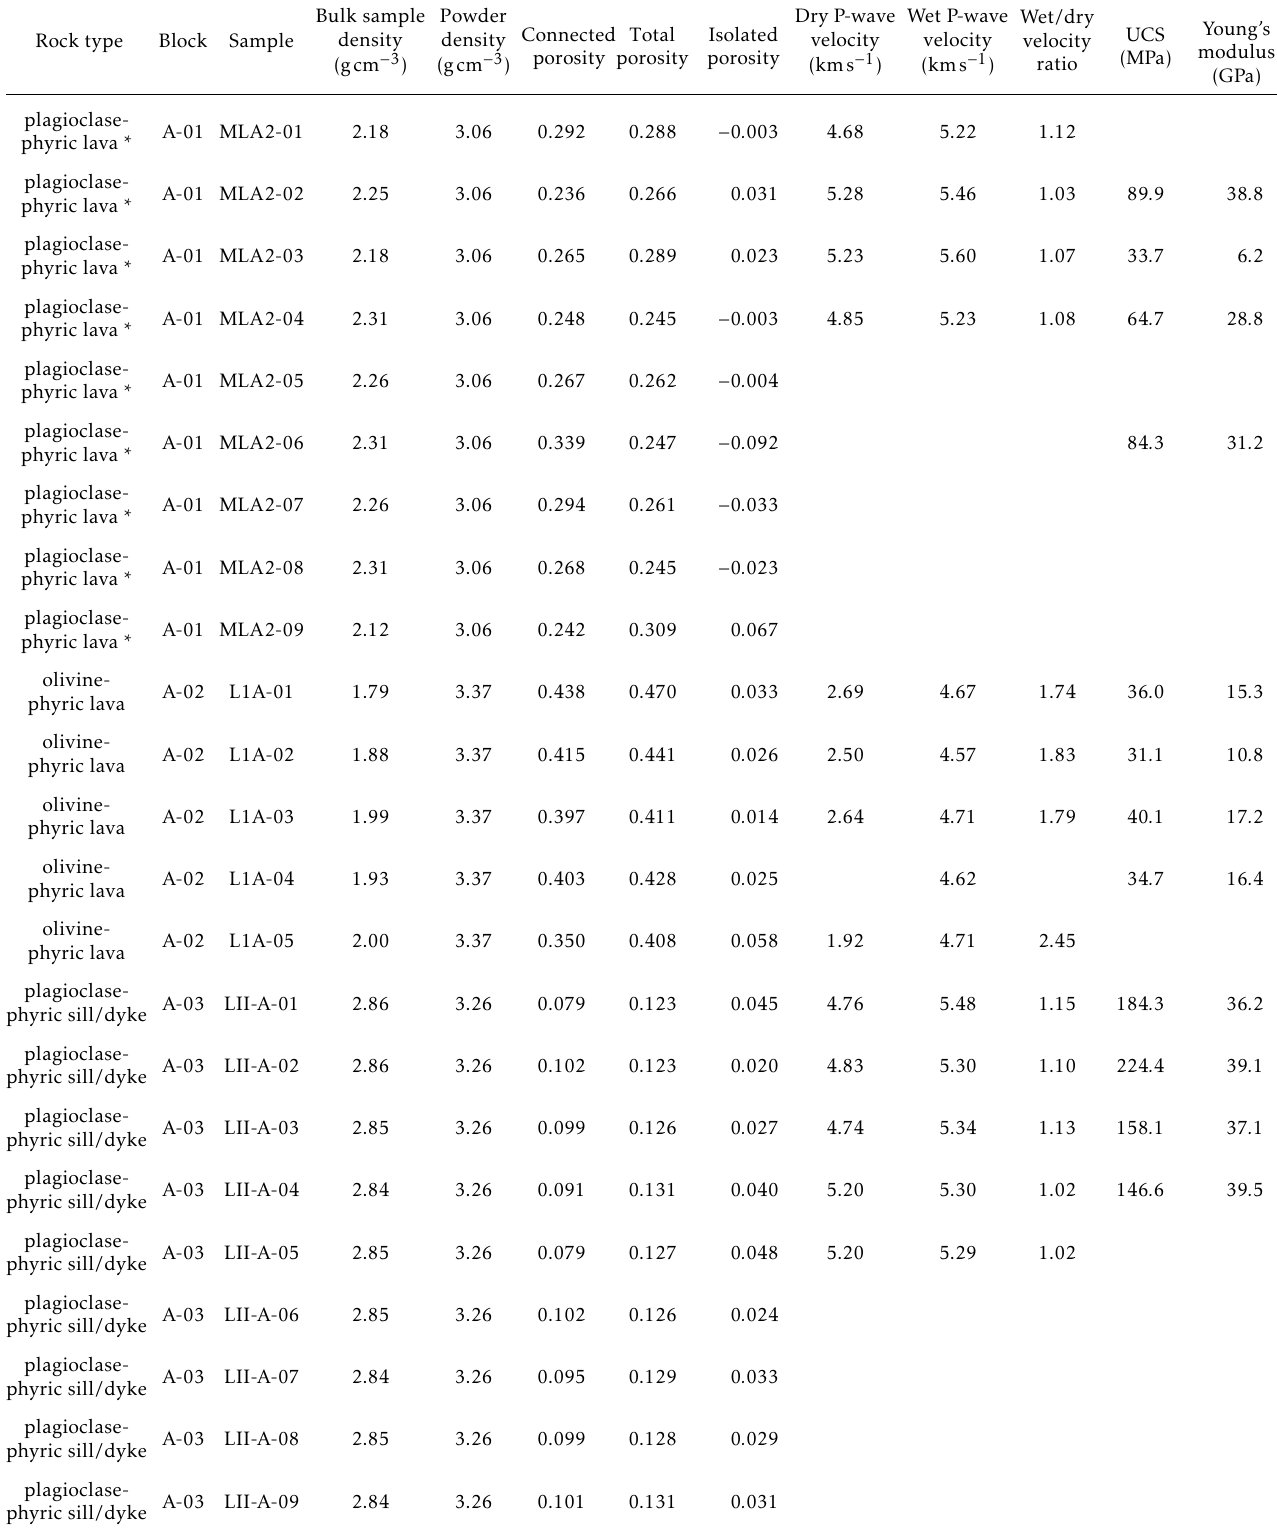
Table A1: Summary of the rock physical property measurements for the samples collected from Piton de la Four- naise (France) for this study. UCS – uniaxial compressive strength. *Presence of zeolites in some of the